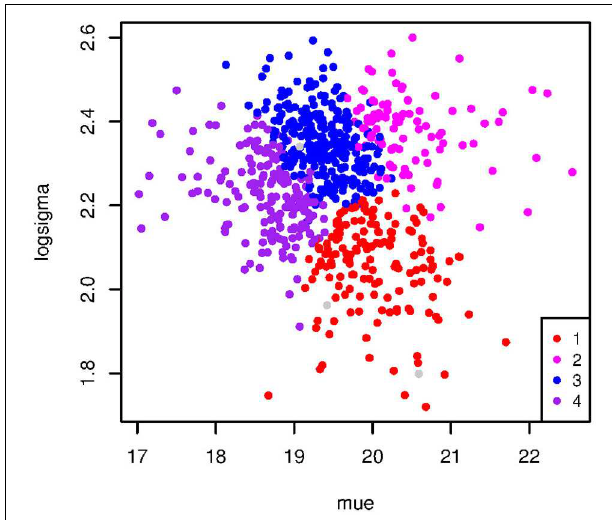
FIGURE 2 | A typical result of a k-means analysis in which the clusters (four here) are clearly distinguishable (from Fraix-Burnet et al., 2010).